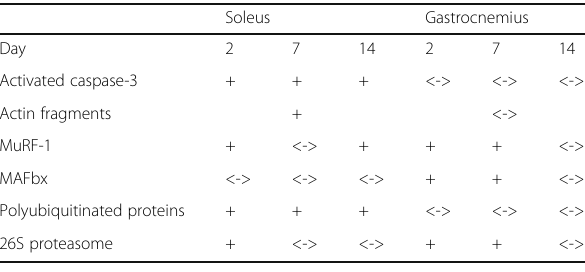
Table 51 (abstract A142). Caspase-3 and ubiquitin-proteasome system